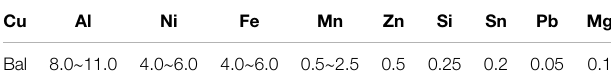
TABLE 1 | The chemical composition of QAl10-5-5 aluminum bronze (wt.%).